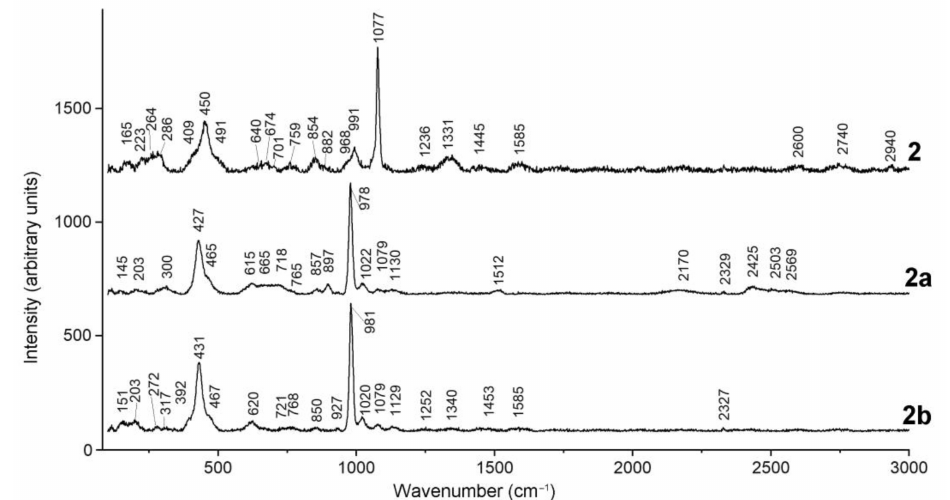
Figure 29. Raman spectra of the products of the Experiments 2, 2a and